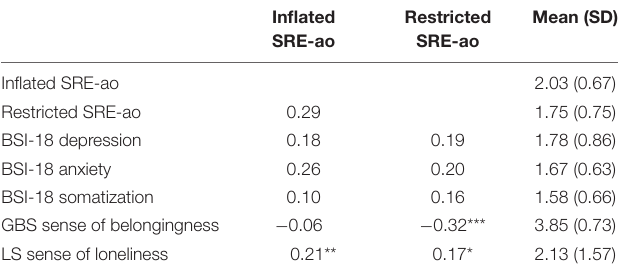
TABLE 1 | Correlations between SRE-ao subscales, BSI-18 subscales, GBS, and LS. Inflated SRE-ao